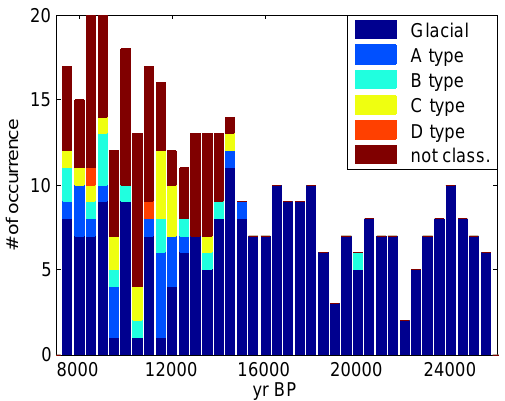
Fig. 5. Histogram of the different REE patterns over time: the ma- jority of the samples before 15000yrBP are classified as belonging to the glacial pattern. During the glacial fewer samples were mea-